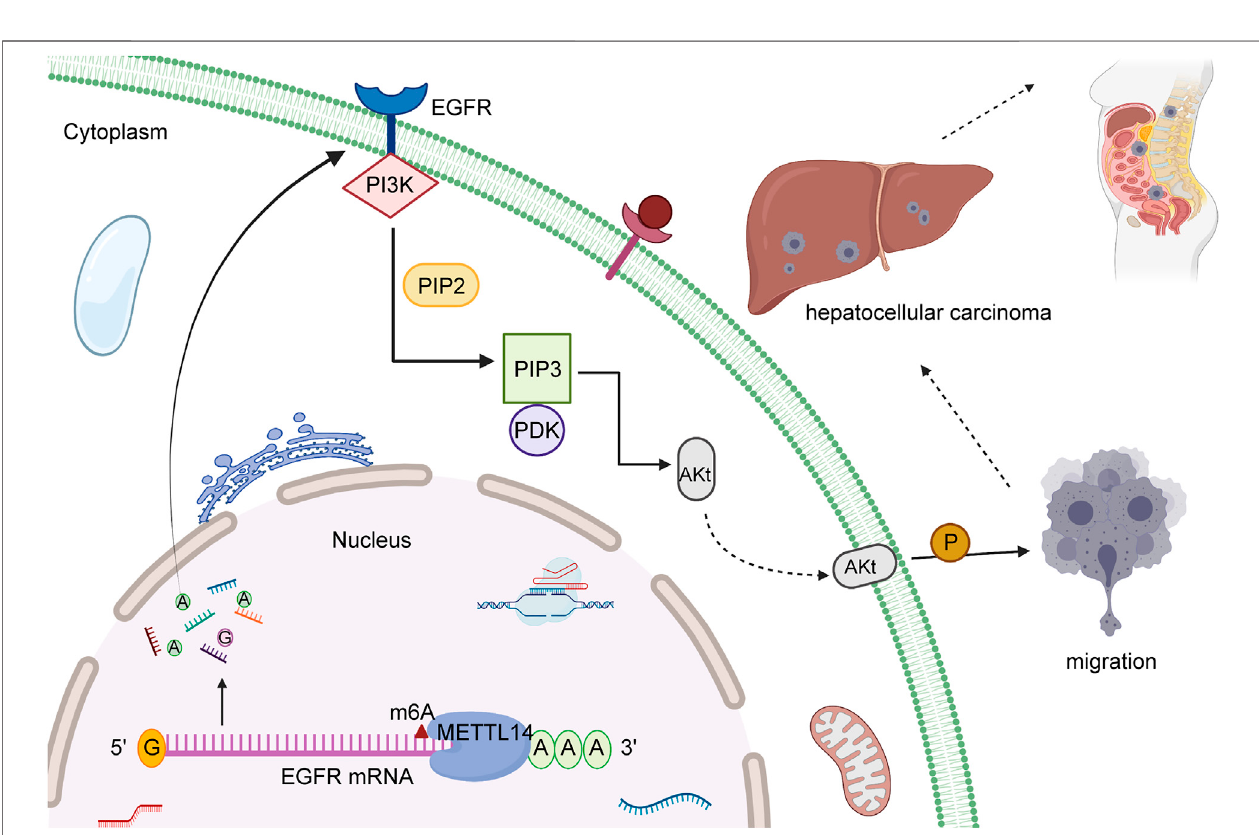
FIGURE 1 | The molecular mechanism of METTL14 in HCC. METTL14, a “ reader ” of m6A methylation, can have a vital impact on inhibiting migration of HCC cells and is regarded as regulator to reduce EGFR mRNA stability through the effect of modi fi cation of m6A.